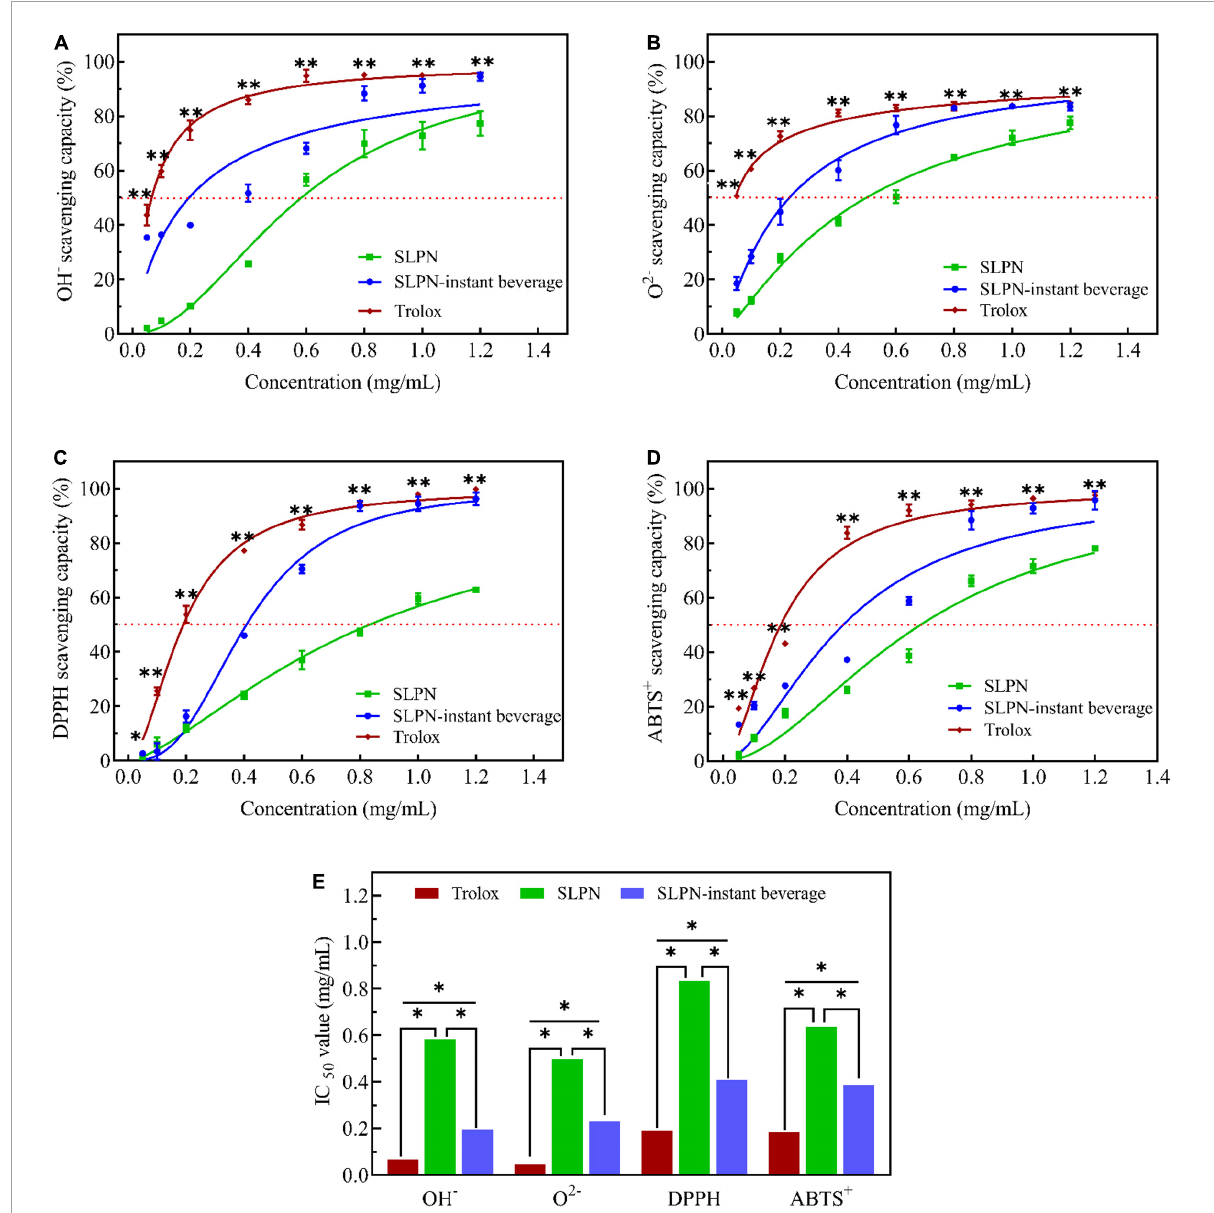
FIGURE6 Scavenging activities of OH - radicals (A) , O 2 − radicals (B) , DPPH radicals (C) , ABTS + radicals (D) , and IC 50 (E) in SLPN and SLPN-instant beverage, Trolox as positive control. *Indicates a significant difference, **Indicates a very significant difference based on ANOVA post-hoc test (including t -test) at P <